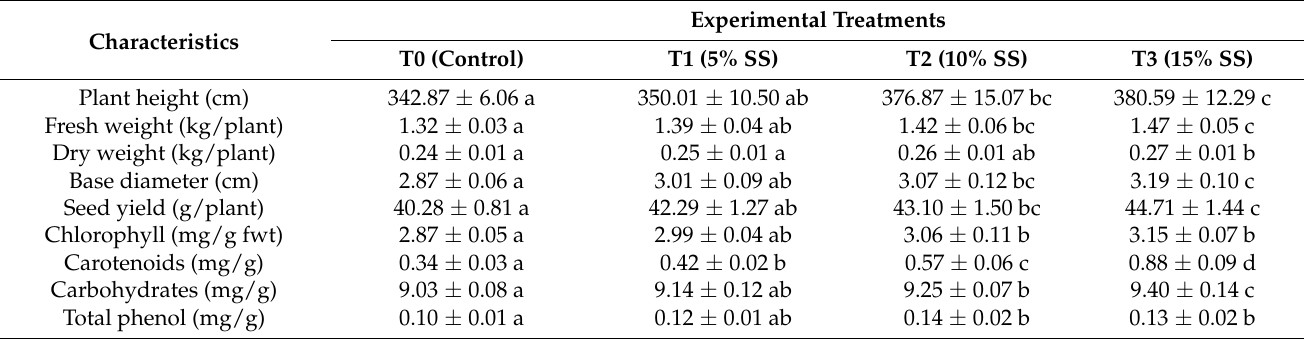
Table 2. Effects of different loading rates of sewage sludge on growth and biochemical characteristics of cultivated dhaincha ( S. bispinosa